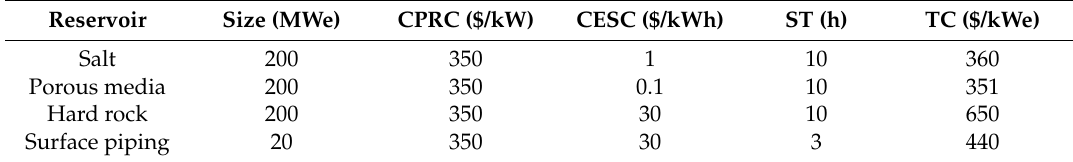
Table 2. Various storage media and plant configurations of air storage reservoir [9].